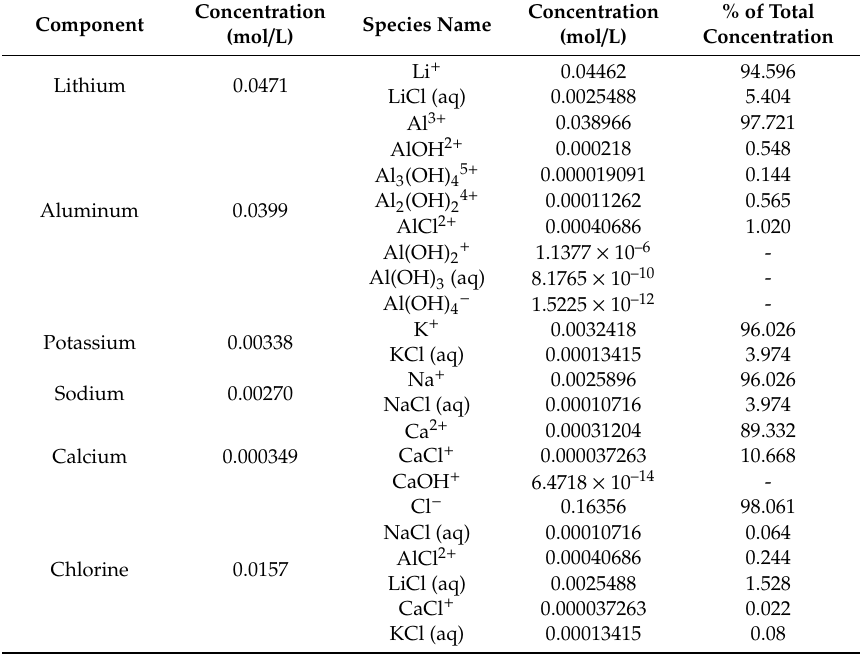
Table 10. Concentrations of ion species in aluminum–lithium solution containing K + , Na + , and Ca 2 +